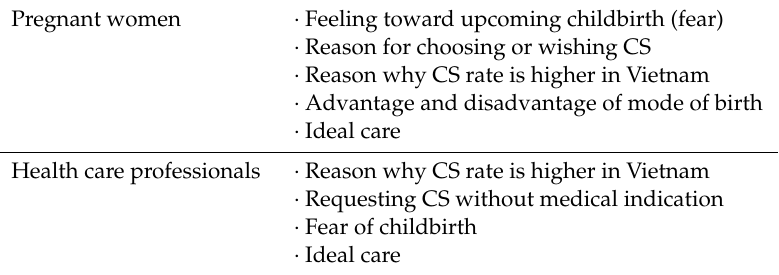
Table A1. Interview